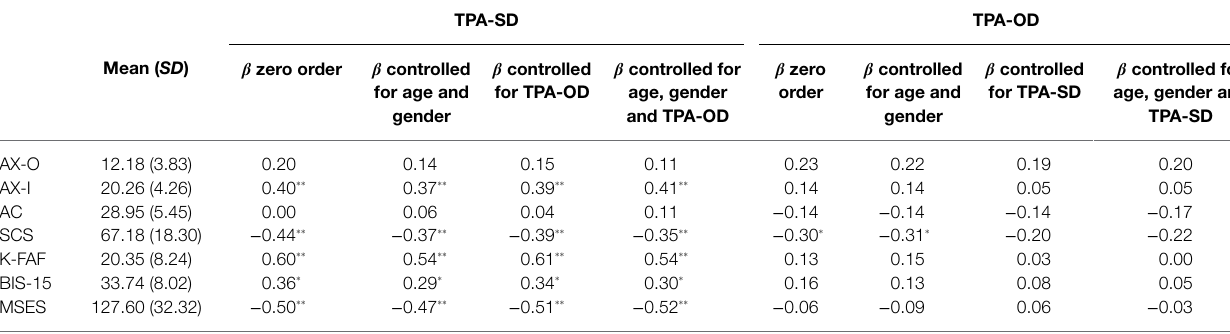
TABLE 2 | Descriptive statistics of study variables and associations with Test of Passive Aggression (TPA)